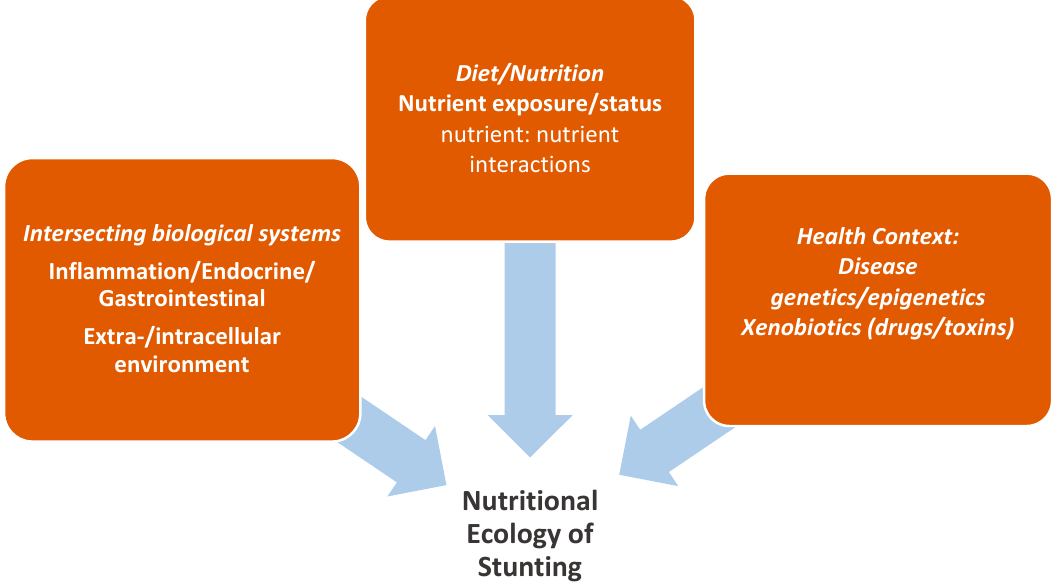
Figure 2. The “Internal” nutrition ecology of stunting.